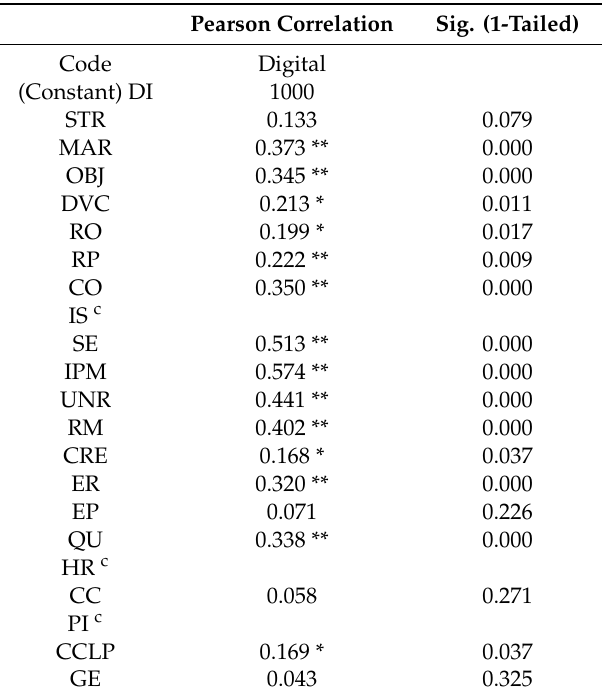
Table 6. Regression